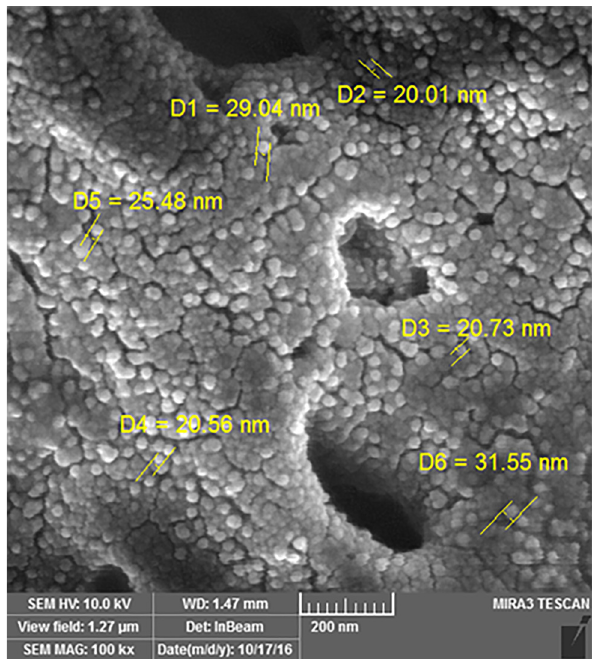
Figure 10: SEM images of the synthesized ZnO NPs at optimum conditions.